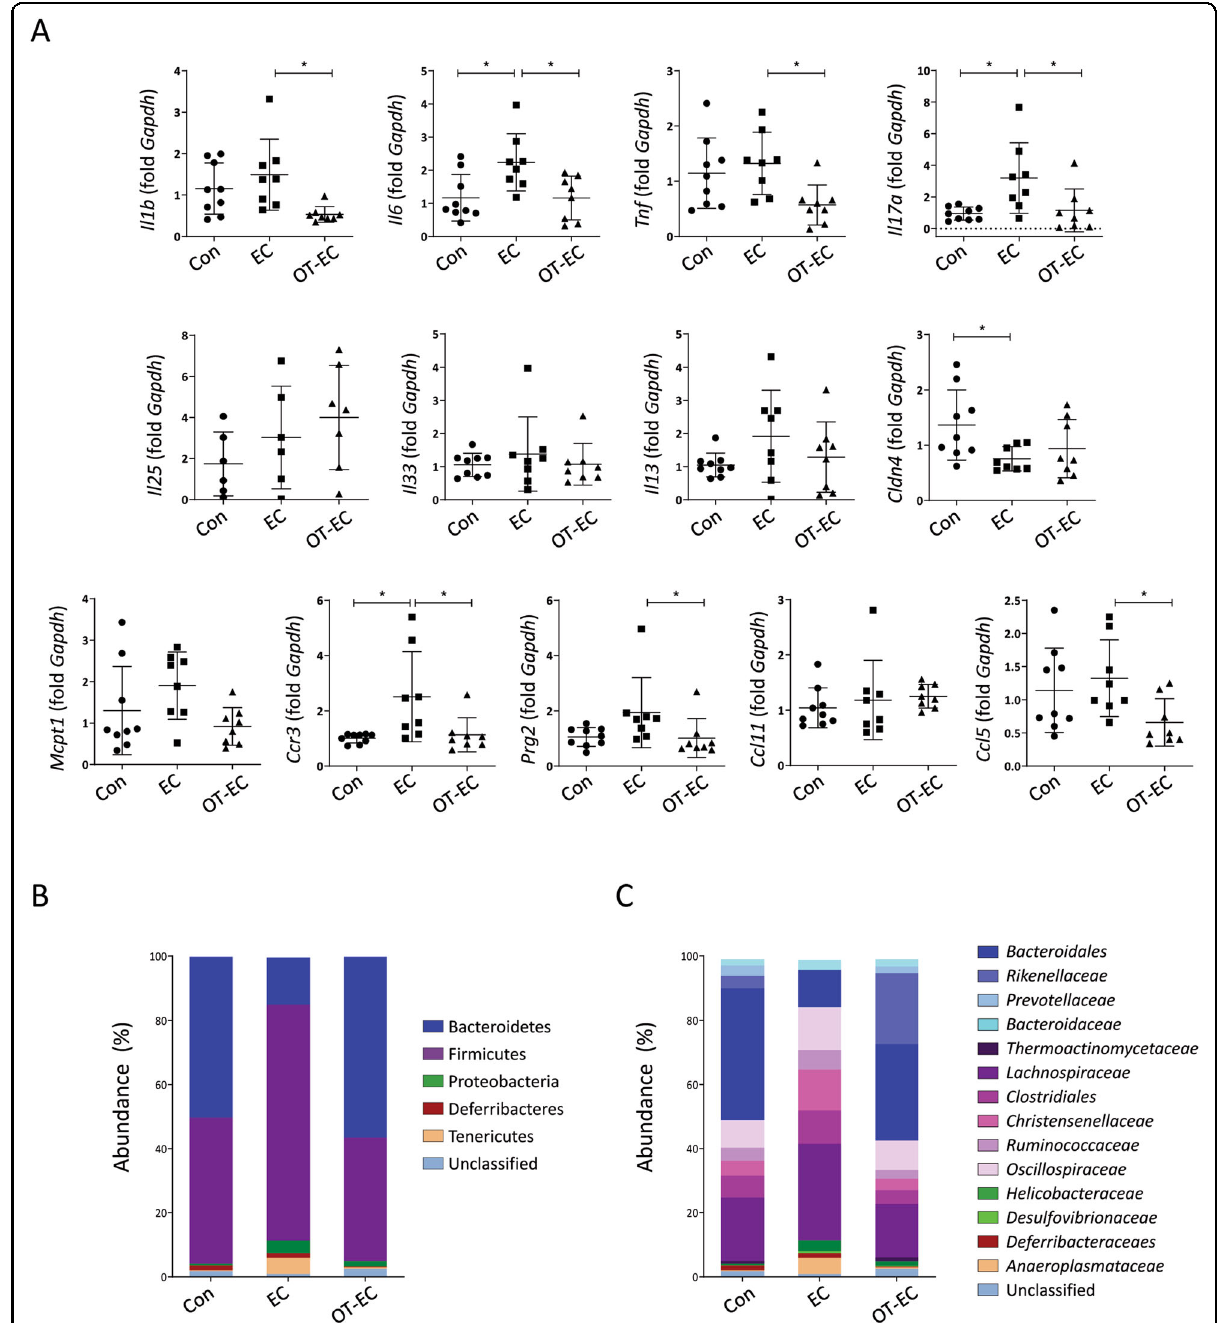
Fig. 3 EC challenge and oral tolerance induction elicited immune microenvironmental changes in the small intestine. A mRNA expression of Il1b , Il6, Tnf , Il17a , Il25 , Il33 , Il13 , Cldn4 , Mcpt1 , Ccr3 , Prg2 , Ccl11 , and Ccl5 in the small intestine of the indicated mice. All data are representative of two independent experiments. The graphs show the mean ± SD values. * P < 0.05 (one-way ANOVA for Il1b , Tnf , Il17a , and Cldn4 ; Kruskal – Wallis test for Il6 , Ccr3 , Prg2 , and Ccl5 ). B and C shows relative abundance at the phylum B and family levels C of microbiota in the cecal contents of the indicated mice. Each column represents pooled samples from the indicated mice ( n = 3 mice per